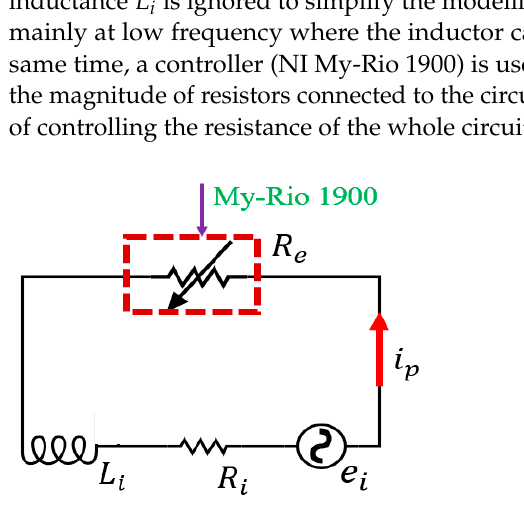
Figure 6. Simplified circuit model of EMD.